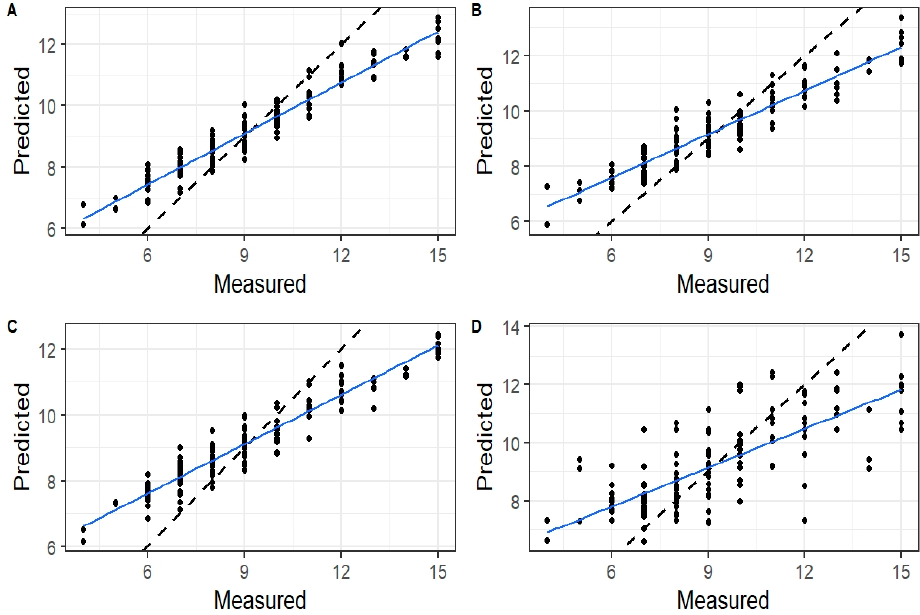
Figure 4. Scatter plot for the Species richness predictions. ( A ) is for Sentinel 2, ( B ) is for RapidEye, ( C ) is for PlanetScope, and ( D ) is for Landsat 8. The blue line is the line of best fit and the dashed line is the 1:1 line as shown on the individual plots.